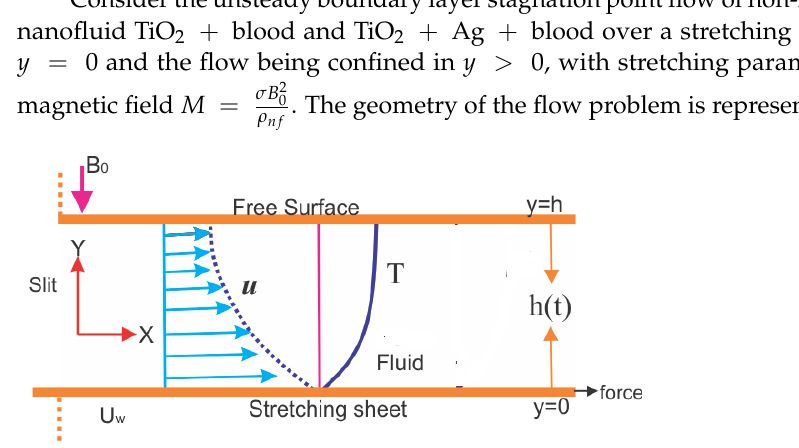
Figure 1. Geometry of the